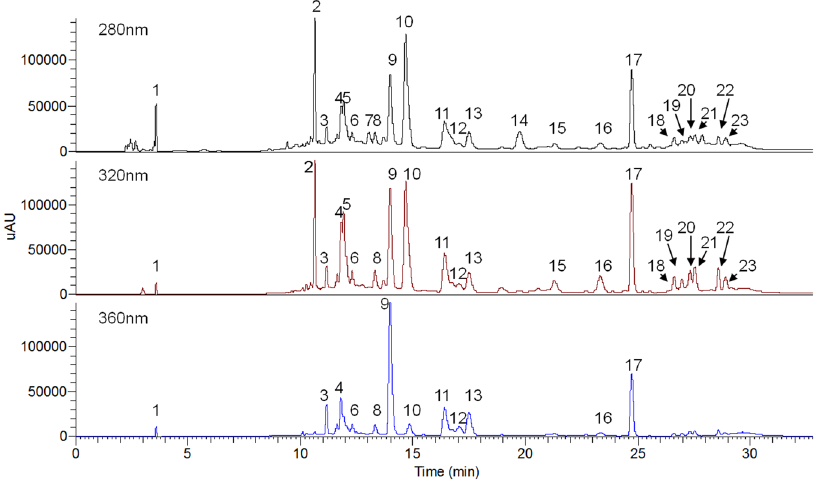
Figure 4. HPLC-PDA chromatograms of phenolic profile in D . indicum var. aromaticum flower under 280 nm, 320 nm, and 360 nm